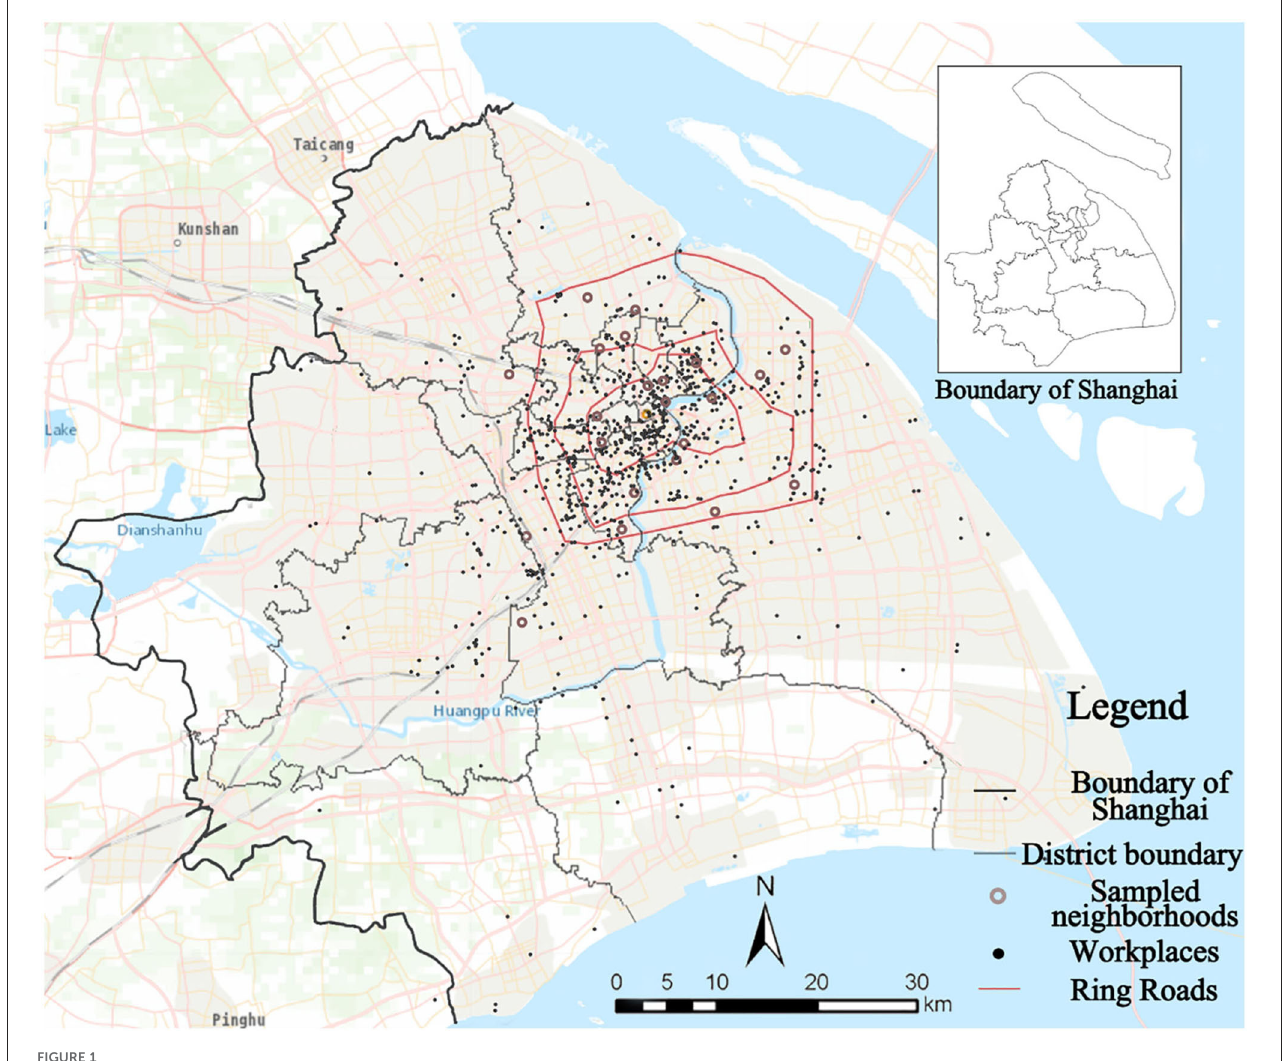
FIGURE1 Distribution of the sampled neighborhoods